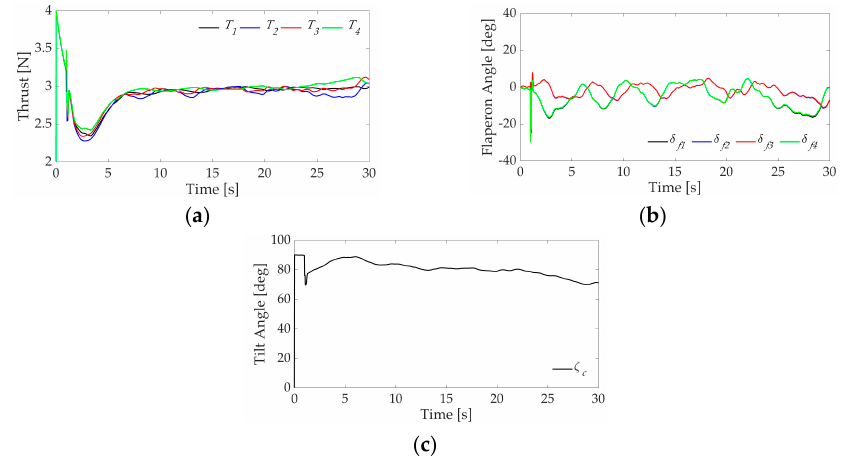
Figure 13. Time responses of control inputs using conventional controller. ( a ) Thrust; ( b ) Flaperon angle; ( c ) Tilt angle.